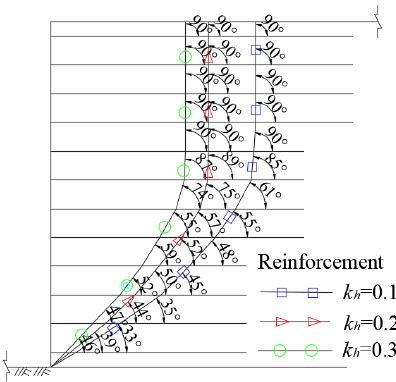
Figure 6. Inclination angle of slip surface and horizontal direction for various k h .